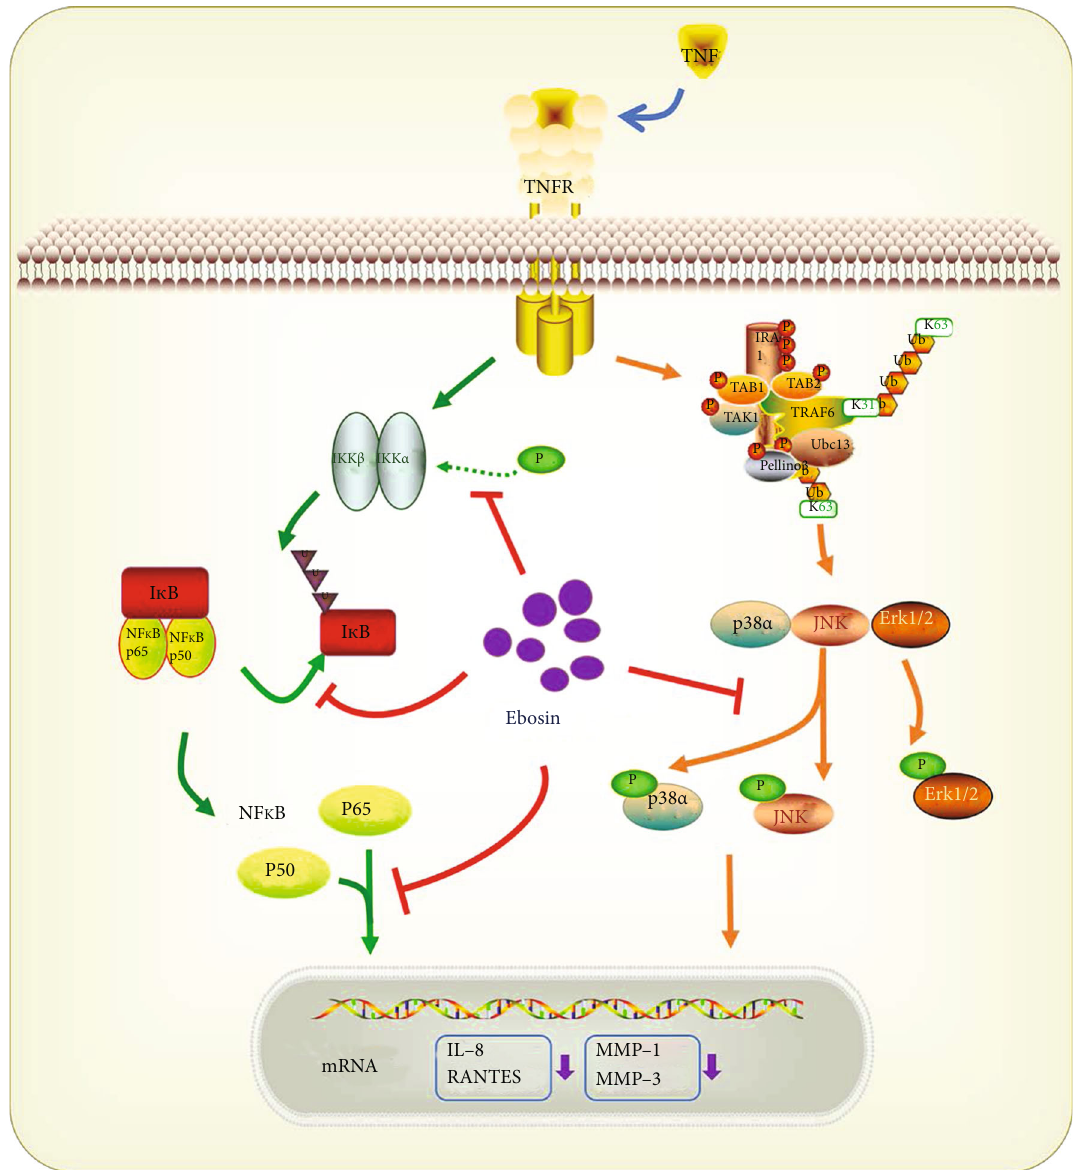
Figure 6: Schematic representation of TNF- α -induced activation of MAPK and NF- κ B signaling pathways modulated by ebosin. The biological e ff ects of TNF- α were attenuated by ebosin on two di ff erent pathways. First, phosphorylation of p38 and JNK MAPK was signi fi cantly inhibited by ebosin with a dose-dependent manner, which may contribute to reduce the nuclear translocation of p38 and JNK. Secondly, it has been shown ebosin can signi fi cantly decrease the phosphorylation level of IKK α and IKK β . And then, the increased level of I κ B with a concomitant decrease in the level of p-I κ B resulted in cytoplasmic retention of NF- κ B p65 and depression of the DNA binding ability of NF- κ B in the nucleus. Finally, the expression of MMP-1, MMP-3, interleukin-8, and RANTES which induced by TNF- α was signi fi cantly reduced responding to ebosin treatment in FLS